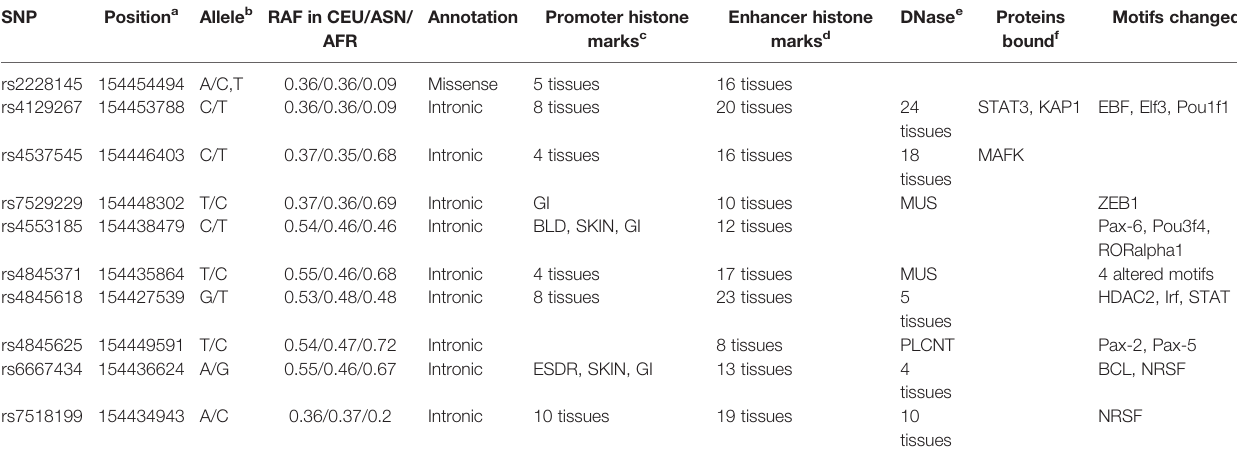
TABLE 4 | Functional annotation of the ten variants showing strong evidence using data from the ENCODE project. SNP Position a Allele b RAF in CEU/ASN/